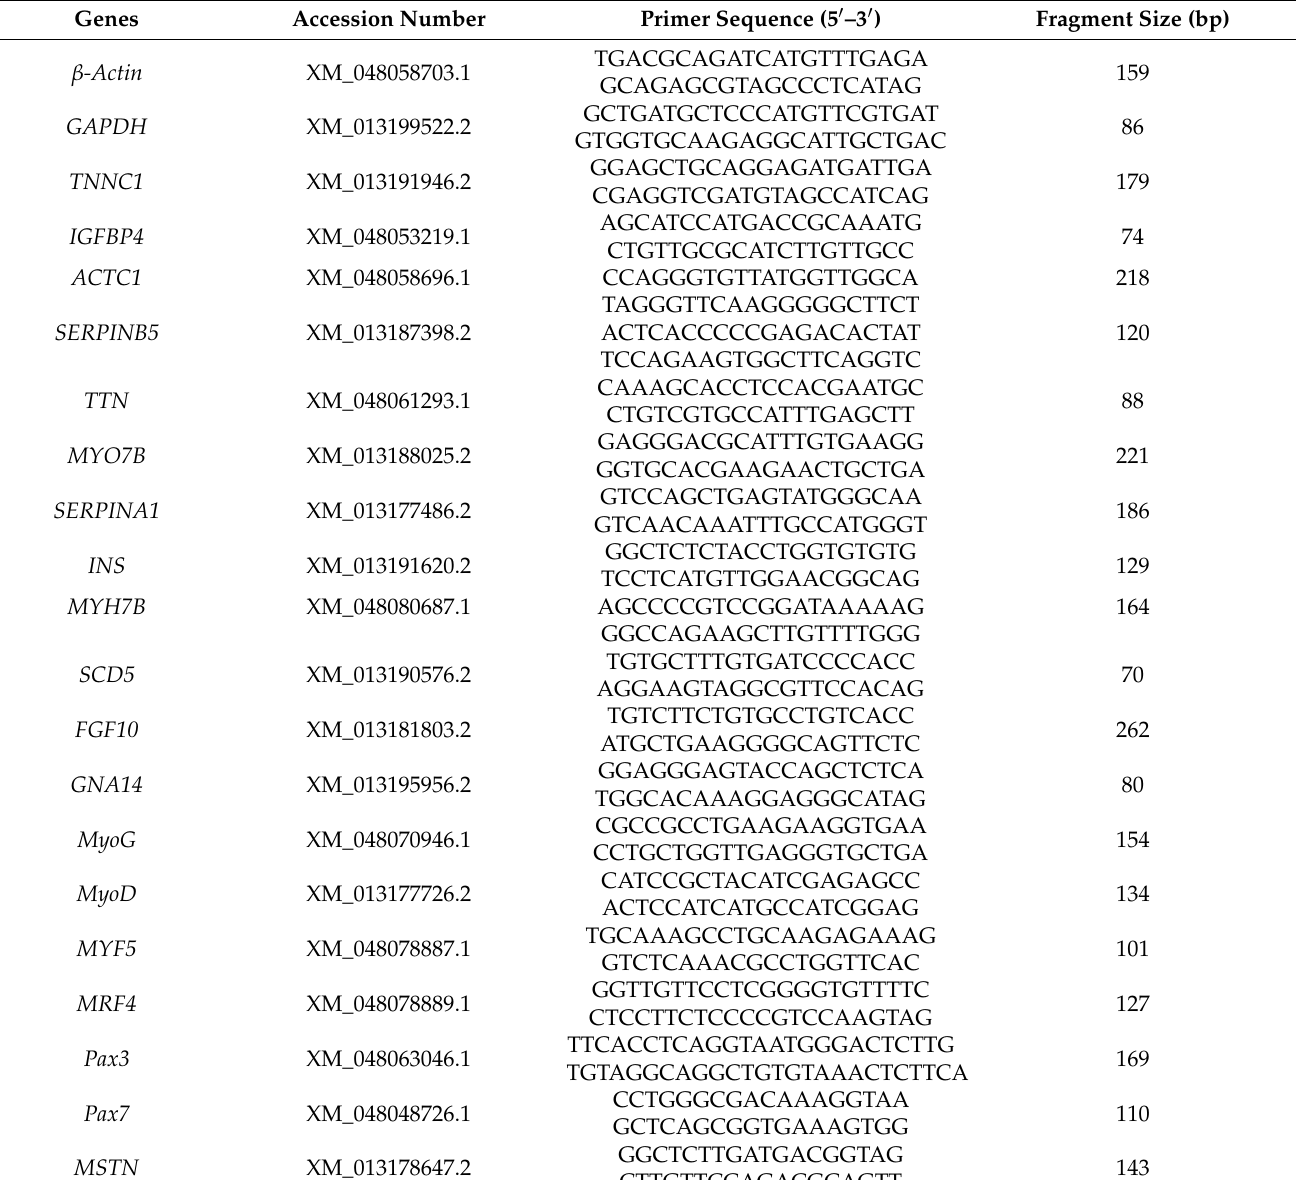
Table 1. The primer sequences for